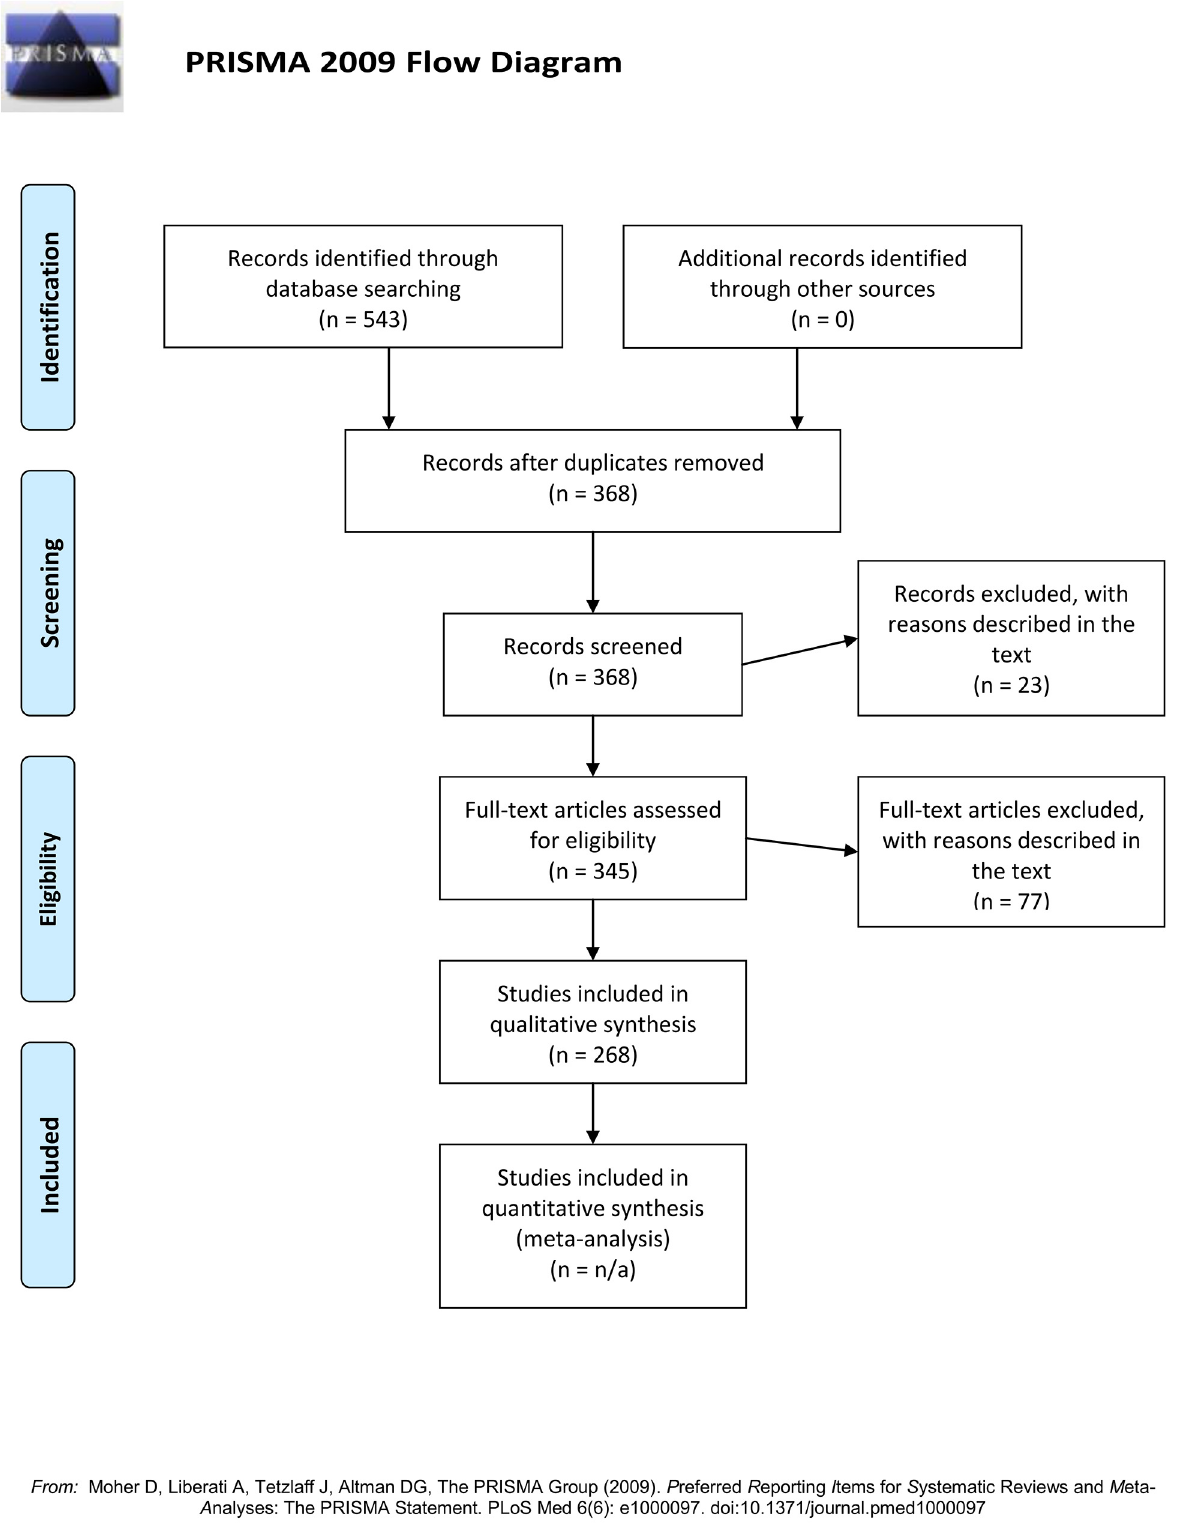
Fig 1. Flow diagram for the systematic review. doi:10.1371/journal.pone.0136928.g001 PLOS ONE | DOI:10.1371/journal.pone.0136928 August 27,